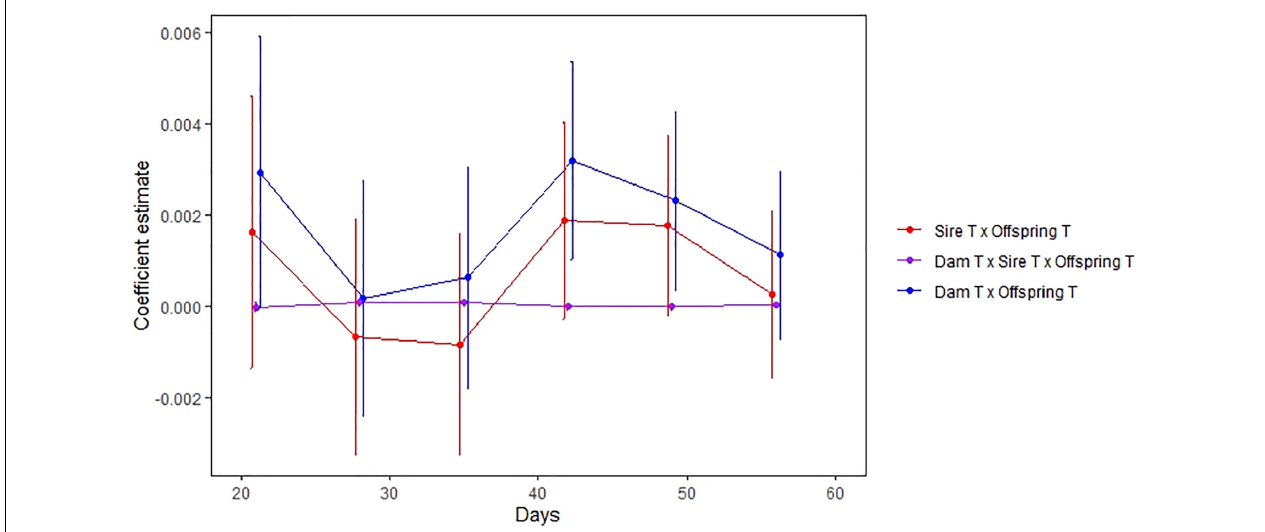
FIGURE 3 | Degree of TGP versus offspring age. The horizontal axis is the age (days) of offspring and the vertical axis is the parent temperature x offspring temperature interaction effect on offspring growth over the previous week. The interaction measures the change in the slope of the growth v. temperature reaction norm attributed to dam (blue) and sire (red) temperature treatments. Effects for dams and sires are largely parallel, with peaks at 20 and 42 days. Error bars denote residual standard